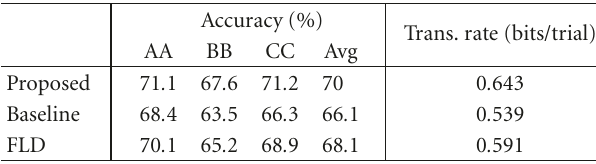
Table 1: A comparison of classification accuracies and information transfer rates of di ff erent methods for di ff erent